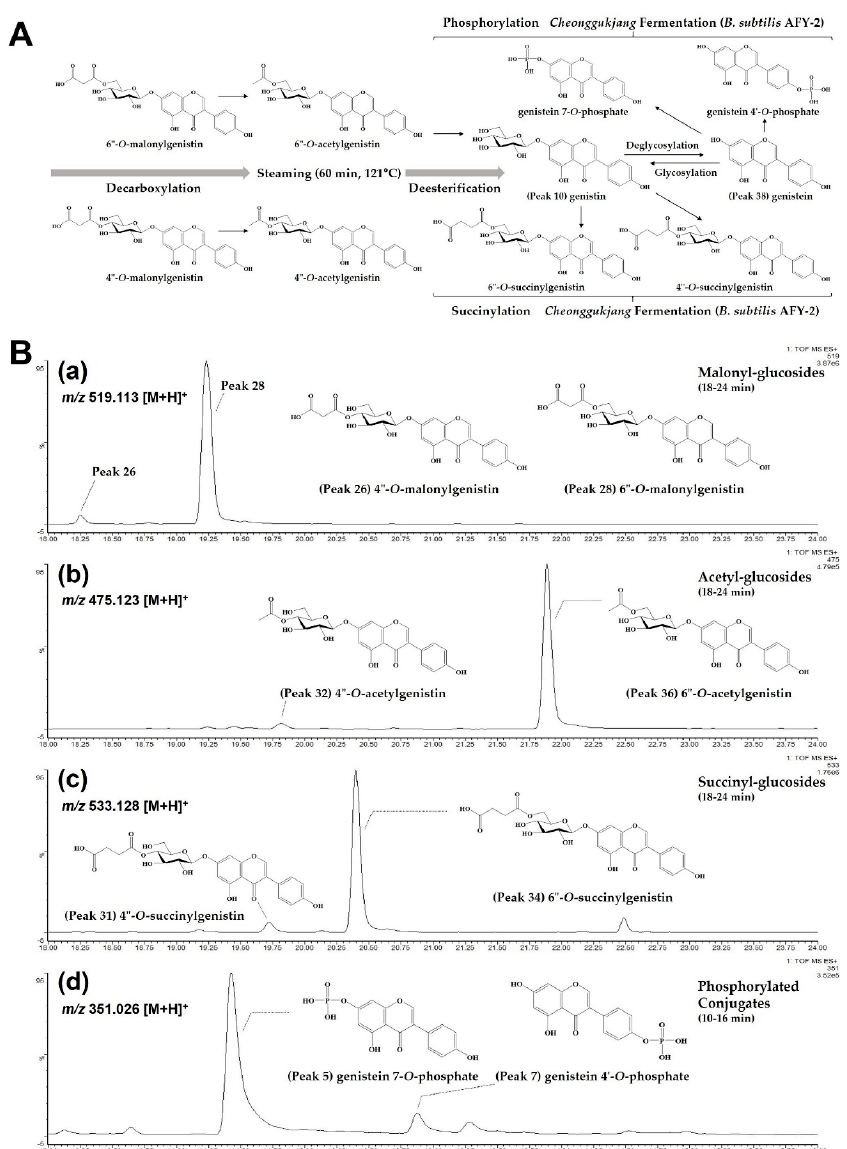
Figure 4. ( A ) A proposed roadmap on biotransformation of soy isoflavones during steaming and cheonggukjang fermentation (by B. subtilis AFY ‐ 2) in soybean seeds; ( B ) ESI(+) ‐ QToF/MS ( m/z [M + H] + ) selected ion chromatograms of genistein ‐ based ( a ) intact form (malonyl ‐ glucosides, 519.113), ( b ) decarboxylation (acetyl ‐ glucosides, 475.123), ( c ) succinylation (succinyl ‐ glucosides, 533.128) and ( d ) phosphorylation (phosphorylated conjugates, 351.026) by bioconversion stage.